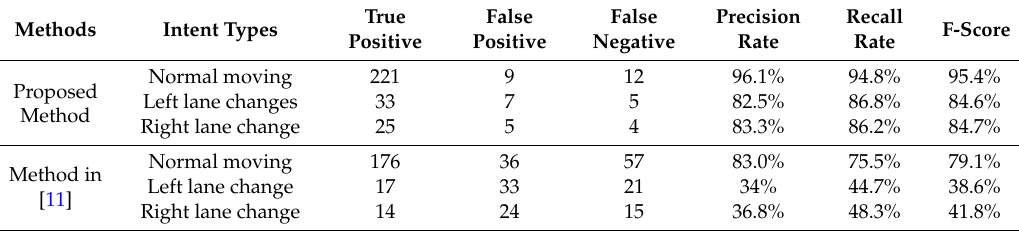
Table 4. Performance on winding roads.